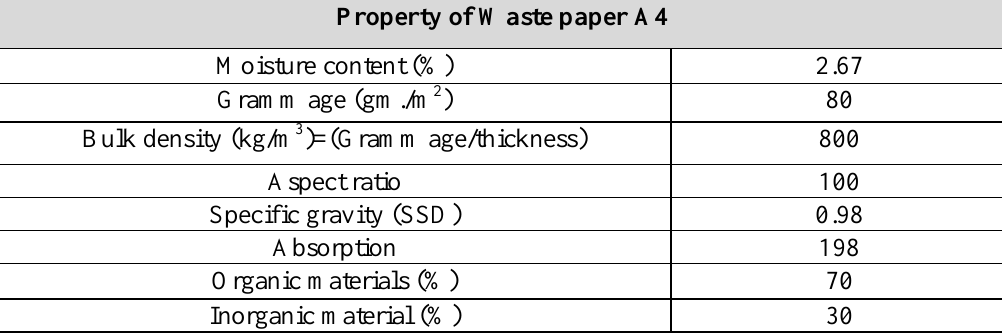
Table 1: Properties of waste paper A4